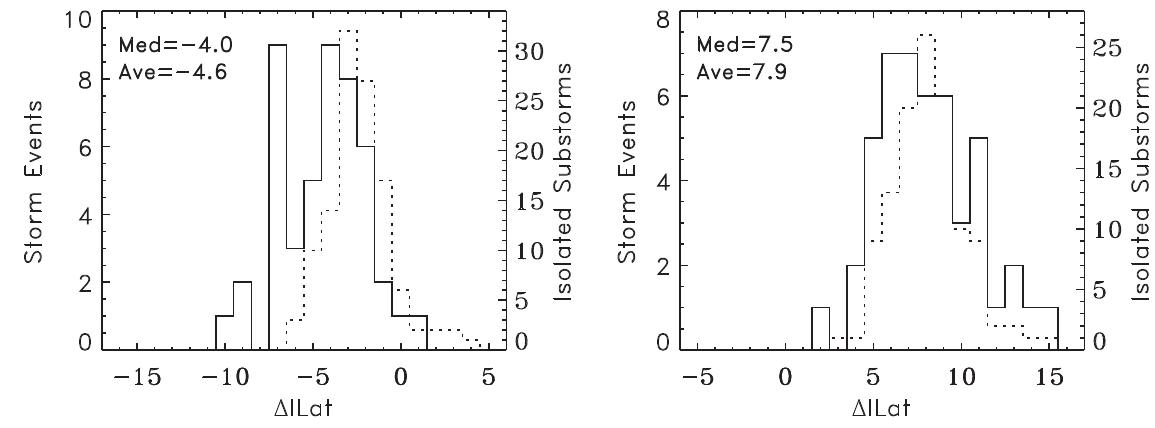
Fig. 11. Expansion of storm-time substorms at the MLT of maximum width with isolated events superposed (dotted lines), equatorward on the left, poleward on the right.